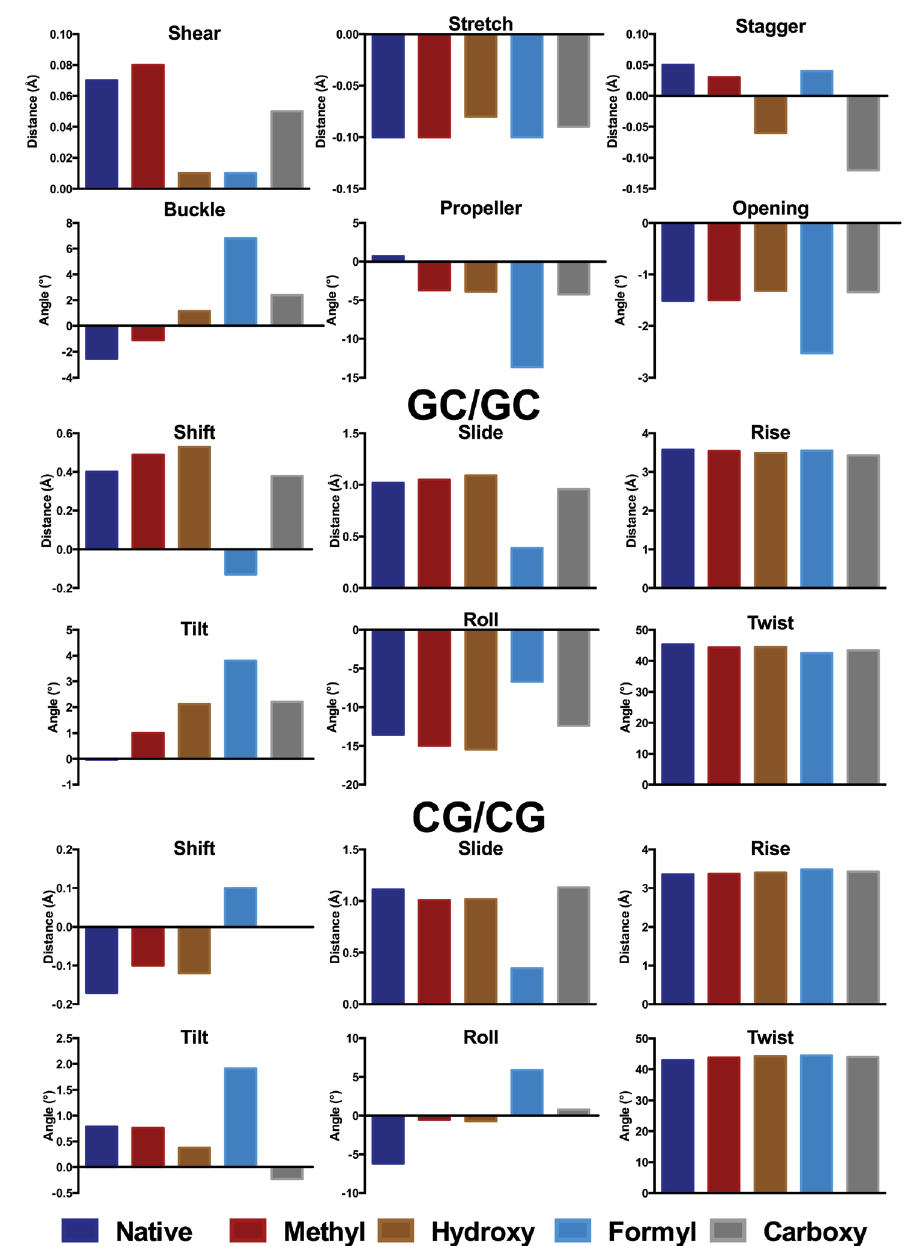
Figure 2. Base pair (A) and step (B, C) parameters for central GC and modifications thereof in d(GCG) (Å and °). The corresponding data are provided in Data file